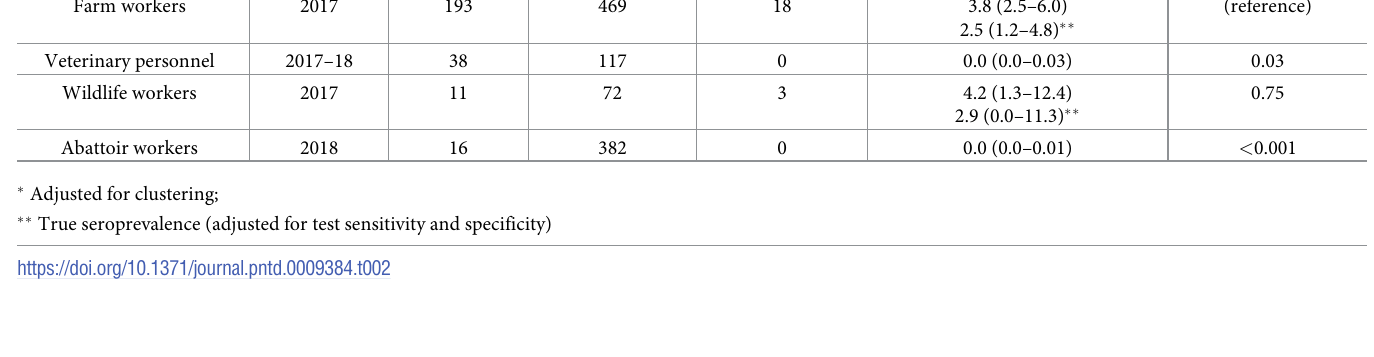
Table 2. Prevalence of antibodies to Crimean-Congo haemorrhagic fever virus by occupational exposure group, central South Africa, 2017–2018. Exposure